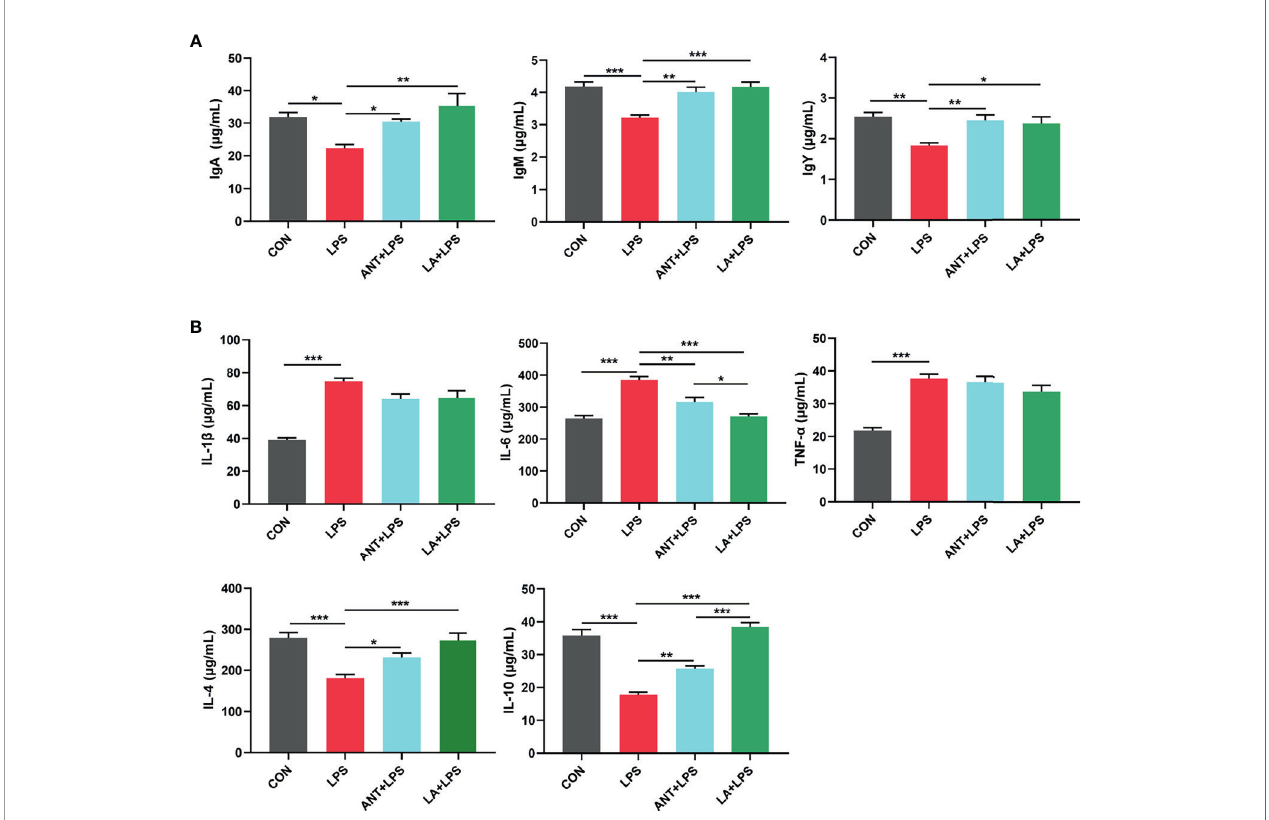
FIGURE 2 | Lauric acid (LA) modulated the immune functions of broilers under lipopolysaccharide (LPS)- challenge. CON: fed with a basal diet and injected with saline; LPS: fed with a basal diet and injected with 0.5 mg/kg LPS; ANT+LPS: fed with a basal diet supplemented with 75 mg/kg ANT, and injected with 0.5 mg/kg LPS; LA+LPS: fed with a basal diet supplemented with 1000 mg/kg LA, and injected with 0.5 mg/kg LPS. (A) Concentrations of serum IgA, IgM, and IgY (B) Levels of serum cytokines (IL-1 b , IL-4, IL-6, IL-10, and TNF- a ). Data shown as mean ± SEM were analyzed by one-way ANOVA and Tukey ’ s test (N = 8 in each group). * P < 0.05, ** P < 0.01, *** P <